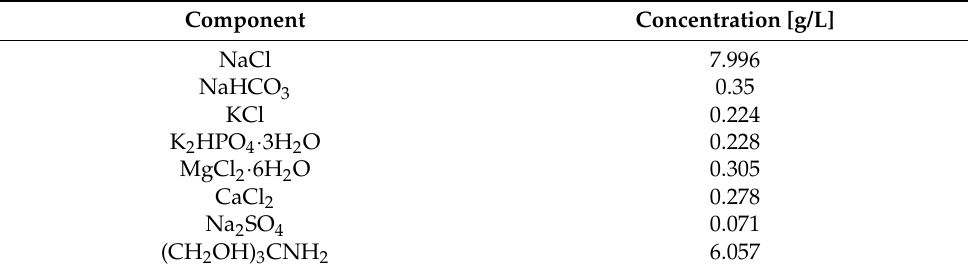
Table 1. Composition of Kokubo SBF [29].